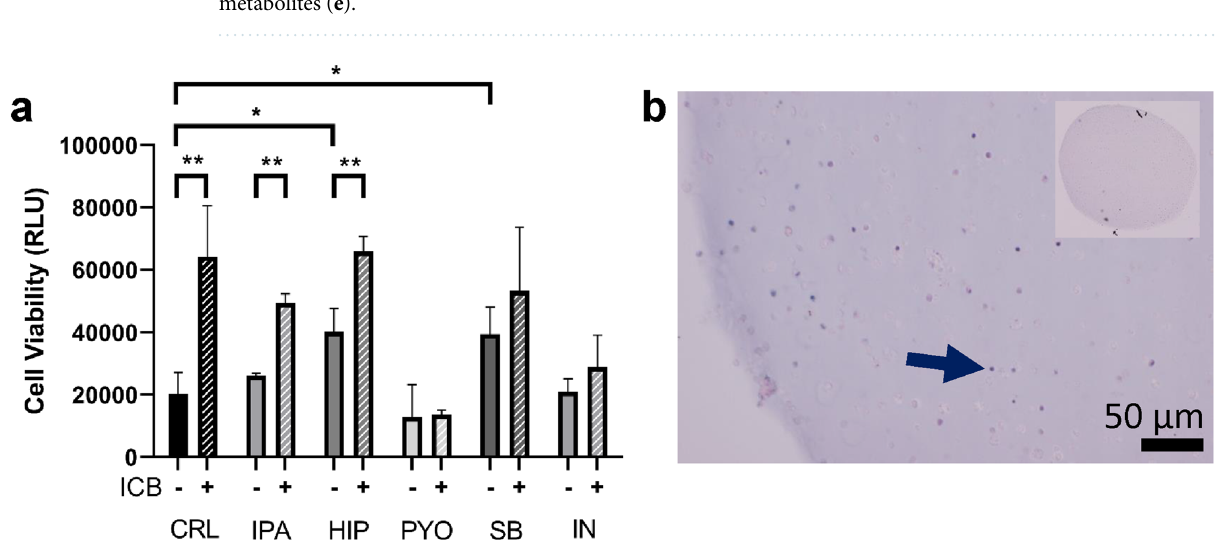
Figure 1. Organoid formulation and general experimental layout. ( a ) Schematic for the construction of the organoids. This equates to 300,000 immune cells and 100,000 cancer cells in each organoid ( b ) Control group that is not treated with bacterial metabolites or ICB for the 5-day course of the experimental trial. ( c – e ) Organoids are treated with ICB alone ( c ), bacterial metabolites alone ( d ), and a combination of ICB and metabolites ( e ).